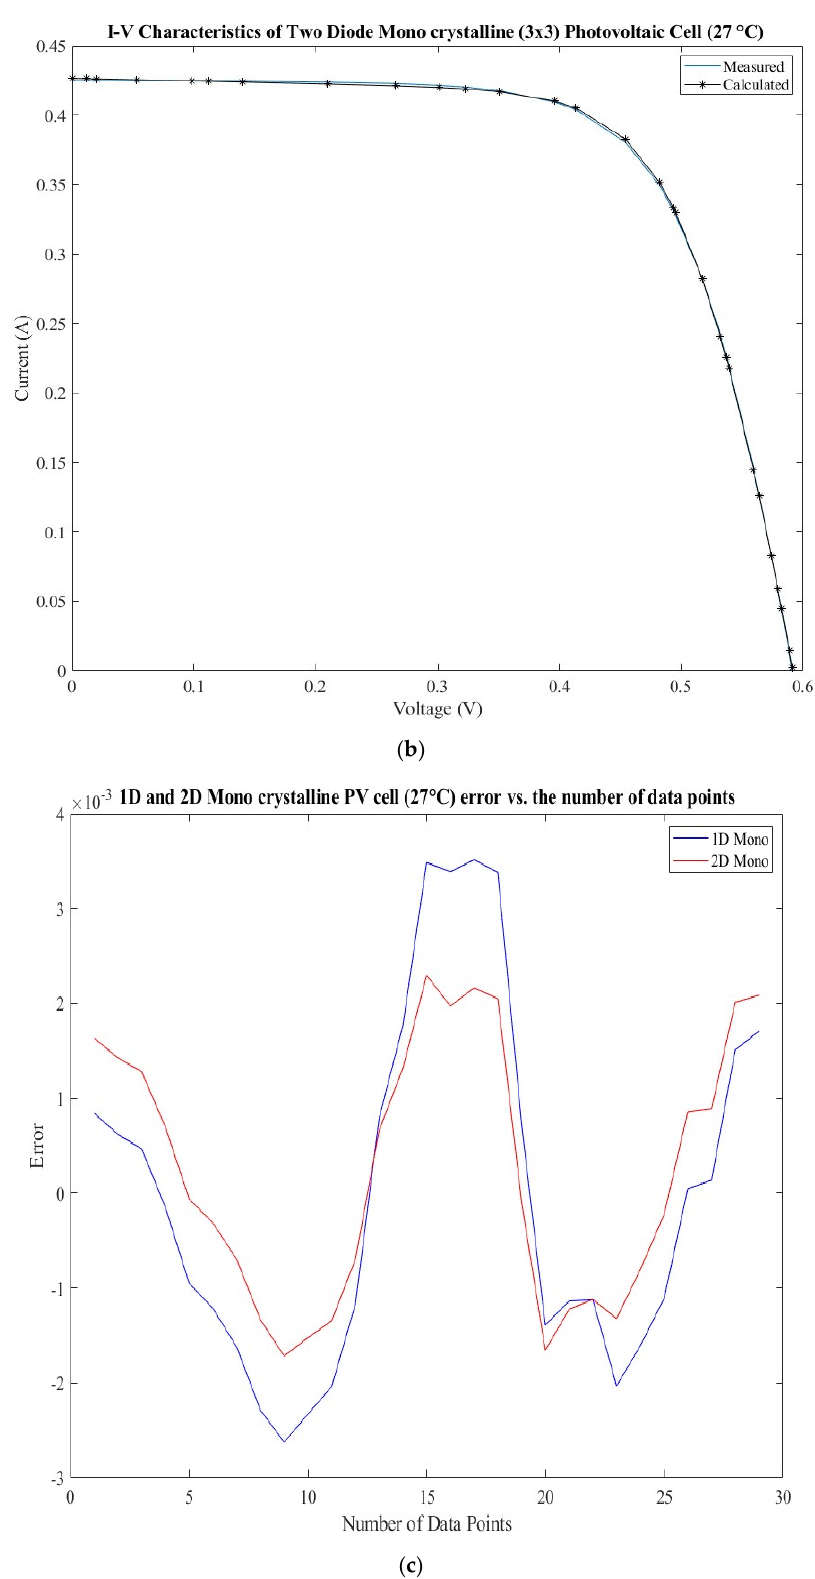
Figure 2 . Monocrystalline silicon photovoltaic cell: ( a ) measured and calculated I-V characteristic for SDM; ( b ) measured and calculated I-V characteristic for DDM; ( c ) SDM and DDM errors comparison .